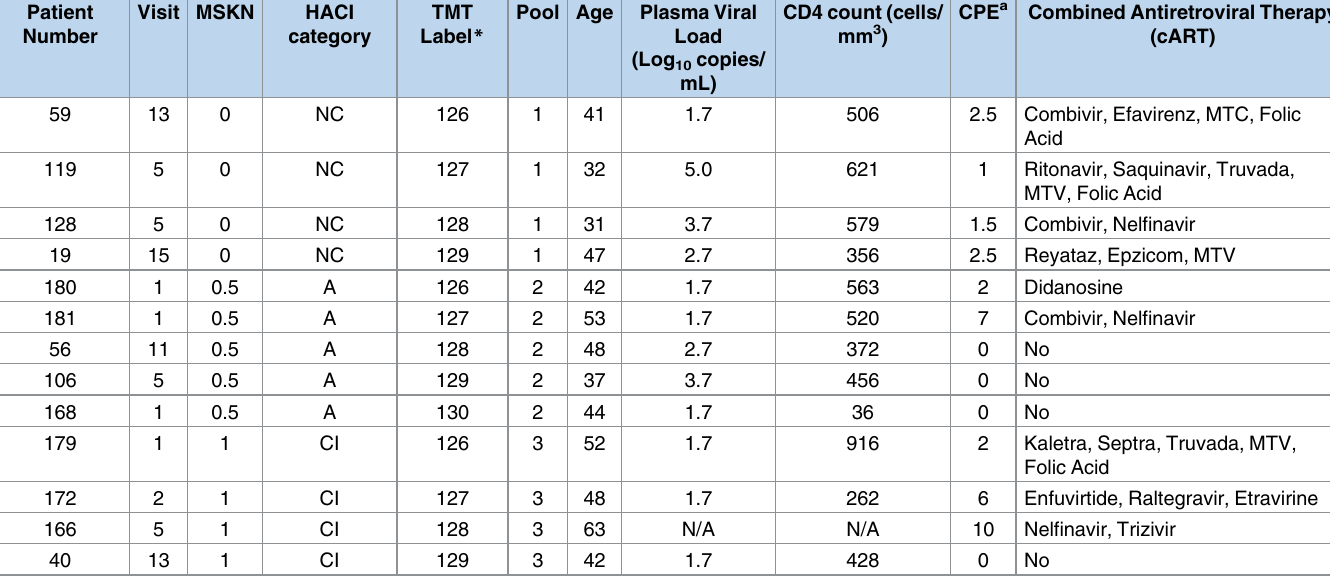
Table 1. Patient samples used for TMT labeling.